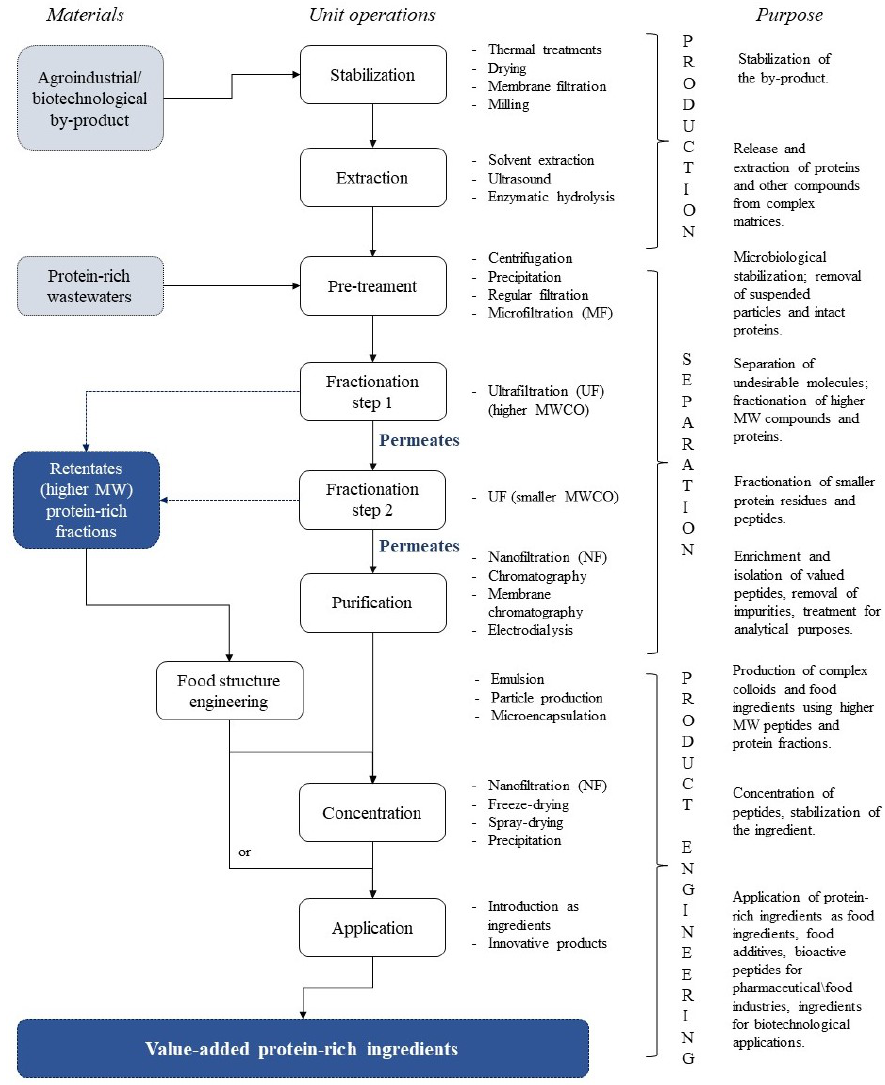
Figure 1. Strategy of processing of agro-industrial, food and biotechnological protein-rich by- products into value-added